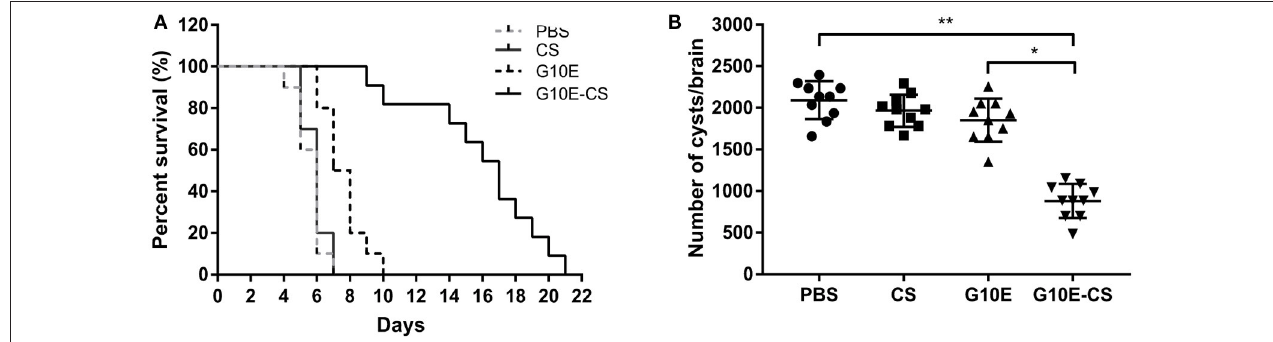
FIGURE 6 | Protection of G10E-CS immunized mice against acute and chronic Toxoplasma gondii infection. (A) Survival rate of vaccinated mice after lethal RH strain tachyzoites challenge. Two weeks after the final immunization, 10 mice per group were intraperitoneally infected with 1 × 10 3 tachyzoites of RH strain and observed daily for mortality. (B) The cyst number in the brain of mice after sublethal PRU strain cyst challenge. 10 mice per group were challenged orally with a sublethal dose of cysts (30 cysts) of the PRU strain (type II). Cyst load was counted from whole brain homogenates of mice 45 days after challenge. Data are representative results of three independent experiments and are represented as the means ± SD. * p < 0.05, ** p <